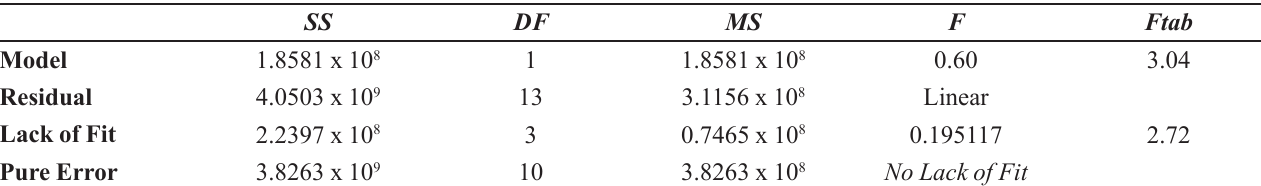
TABLE I – ANOVA linearity results